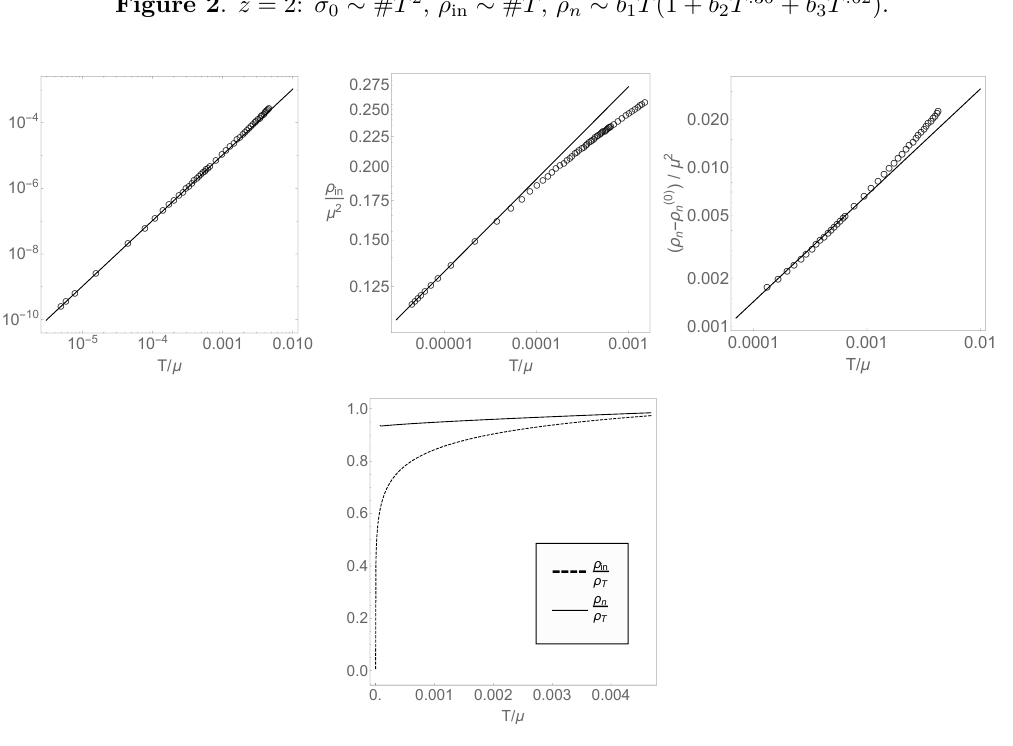
Figure 2 . z = 2 : σ 0 ∼ # T 2 , ρ in ∼ # T , ρ n ∼ b 1 T (1 + b 2 T . 36 + b 3 T . 62 ) .